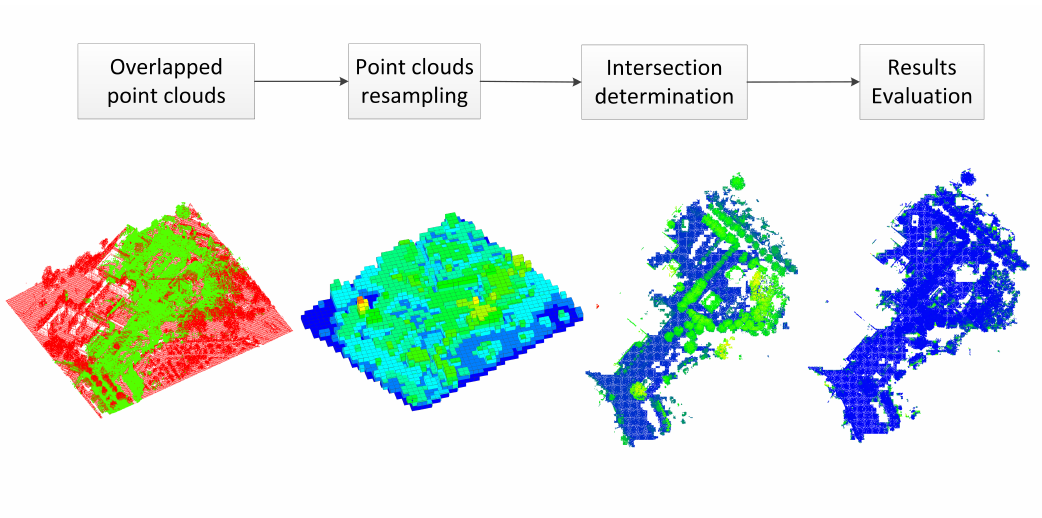
Figure 1: Overall methodology of the algorithm